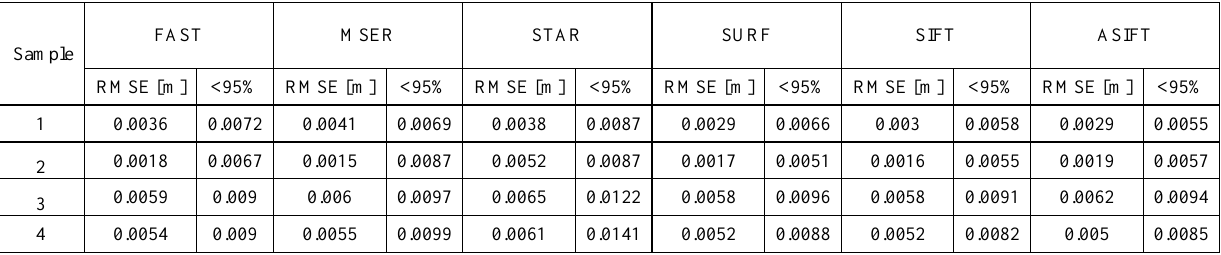
Table 6 RMSE errors of deviations between point clouds and values of deviations for 95%